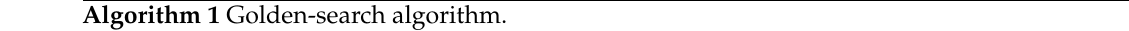
Algorithm 1 Golden-search algorithm.